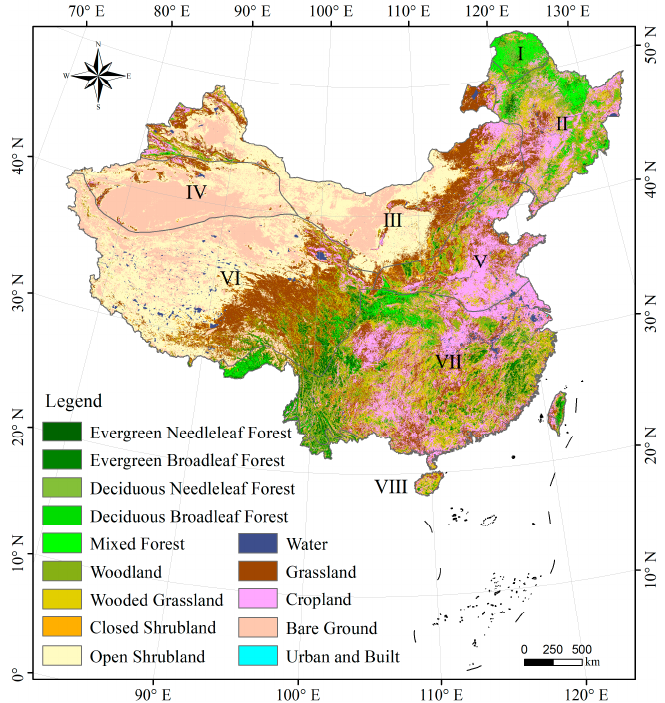
Figure 1. Climate zones and vegetation types in China. The base map is derived from moderate resolution imaging spectroradiometer (MODIS) product MCD12Q1 C5.5 (500 m spatial resolution) based on the University of Maryland (UMD) global vegetation classification scheme in 2010. ( Ⅰ ) Cold temperate humid region, ( Ⅱ ) midtemperate humid region, ( Ⅲ ) midtemperate semiarid region, ( Ⅳ ) warm temperate arid region, ( Ⅴ ) warm temperate subhumid region, ( Ⅵ ) plateau zone, ( Ⅶ ) subtropical humid region, and ( Ⅷ ) tropical humid region. Table 1. Datasets of the satellite-based gross primary production (GPP) used in this study. Temporal Release time Product Description Spatial resolution resolution MODIS GPP product derived MODIS from satellite observations 500 m 8-day 10/2015 (MOD17A2H.006)